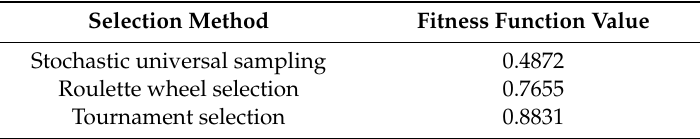
Table 3. Optimization results for different selection methods.